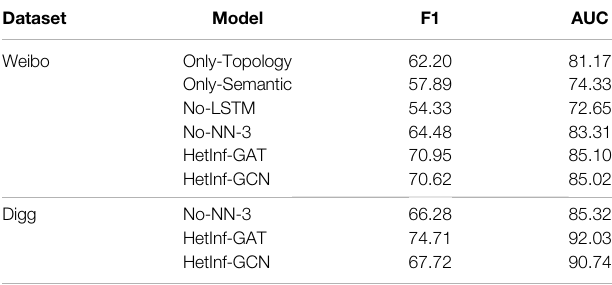
TABLE 4 | Statistics of the datasets. Dataset